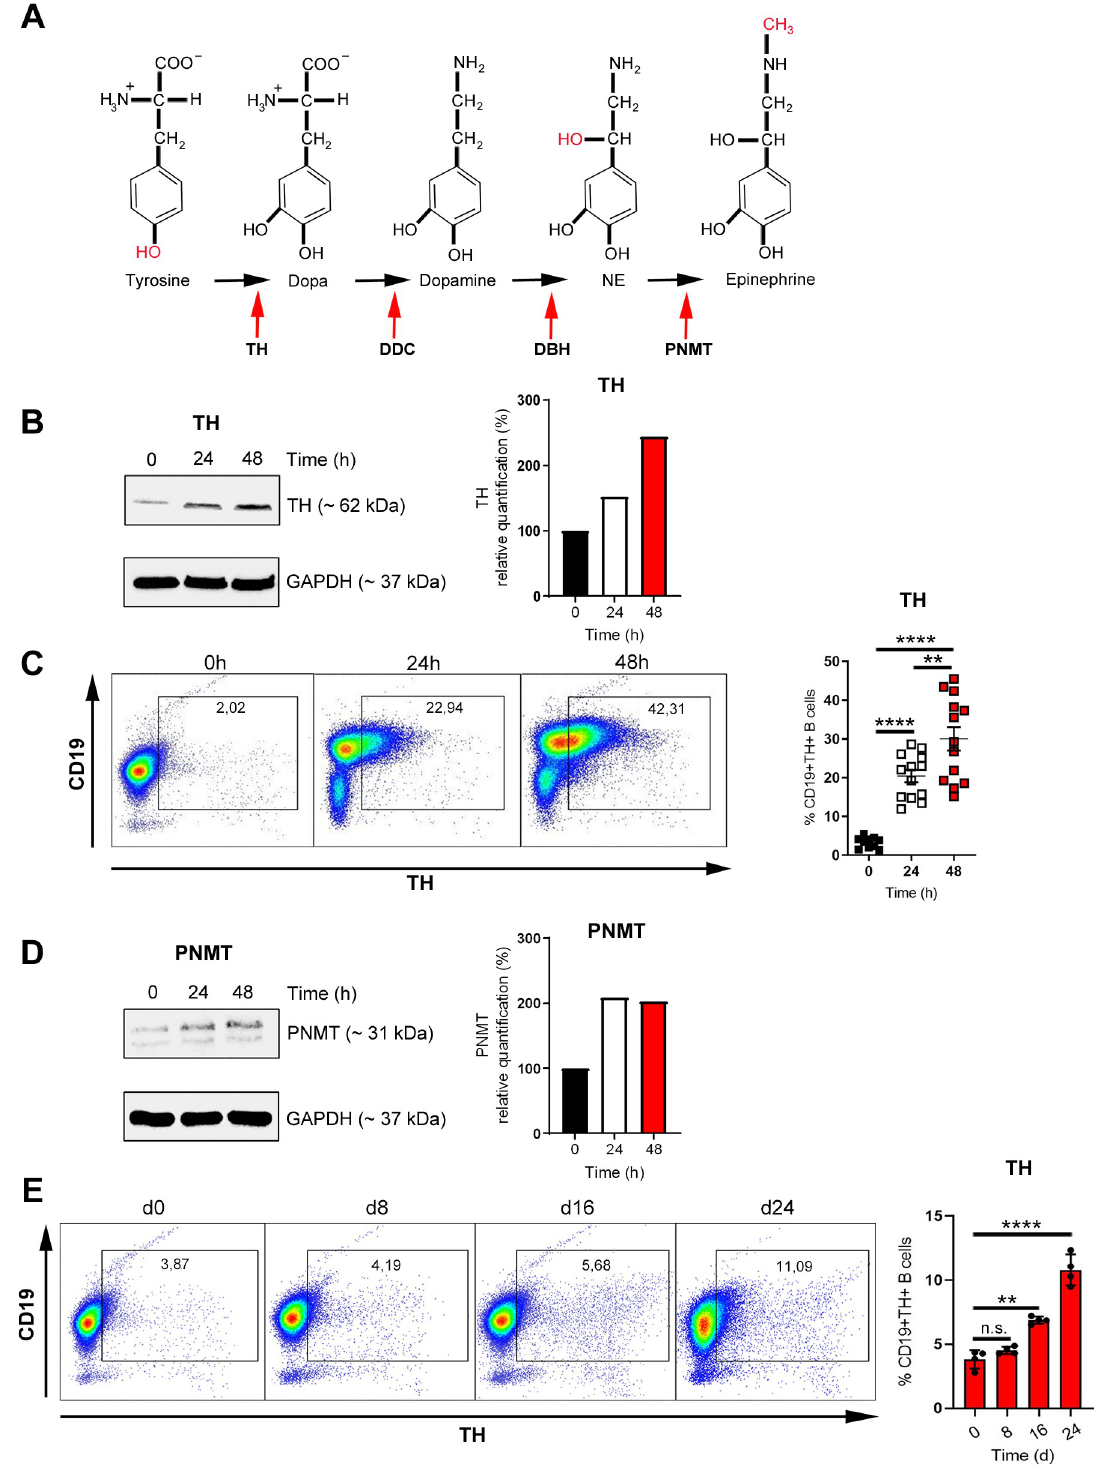
Fig 1. B cells have their own machinery for catecholamine synthesis. ( A ) Graphical depiction of the catecholamine biosynthetic pathway. ( B–D ) B cells were activated with anti-IgM/CpG for 24 or 48 h or left nonactivated. The expression of TH was analyzed by western blot (B) and flow cytometry (C; 0 h: n = 10; 24 h, 48 h: n = 13). Expression of PNMT was investigated by western blot (D). One representative blot of 3 is shown (B, D; n = 3). ( E ) DBA/1J mice were immunized with 100 μ l of an emulsion of CII and CFA. After 0,